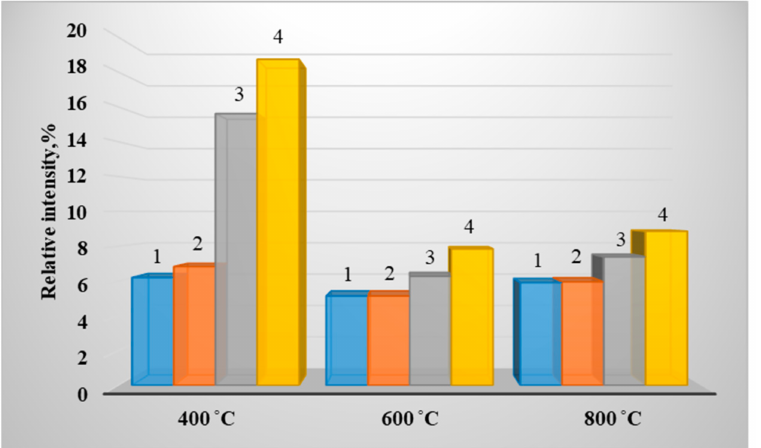
Figure 9. Change in the content of calcium sulfate in ash mixtures of the aggregate (5 + 1) particles of lean coal of grade T and wood during their pyrolysis: 1. Coal T_100%; 2. Coal T_90%/Wood_10%; 3. Coal T_75%/Wood_25%; 4. Coal